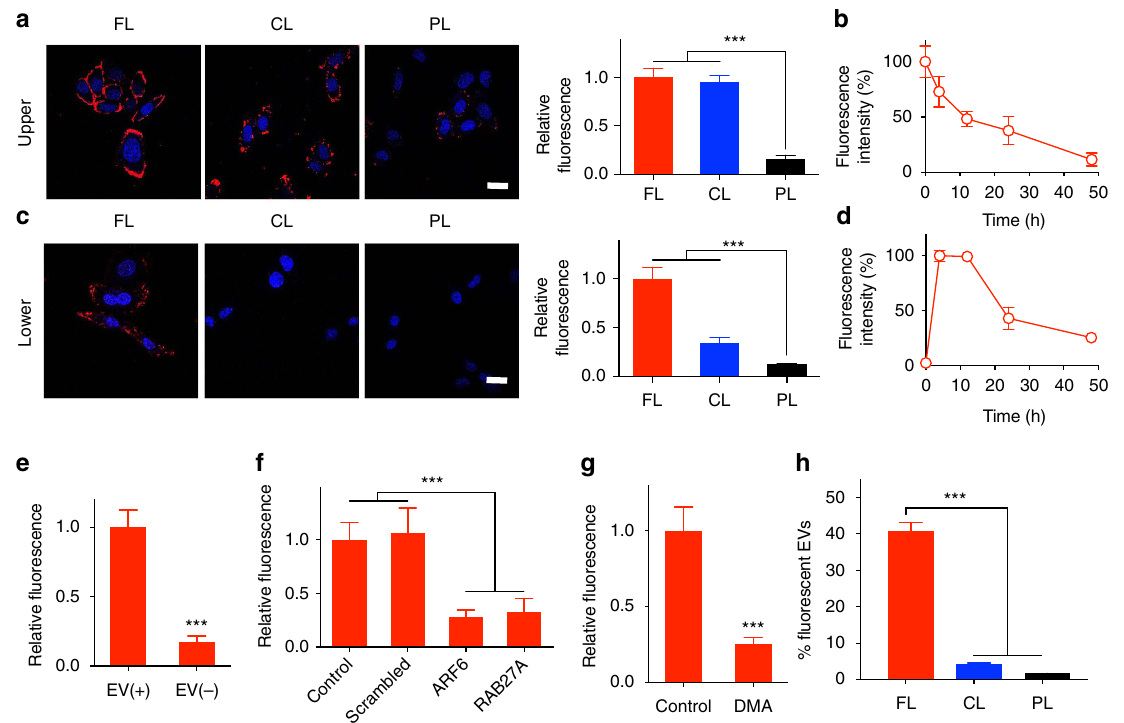
Figure 2 | Cell membrane-selective delivery and EV-mediated intercellular transfer of SR-lipids. ( a ) Confocal fluorescent microscopic images and fluorescence quantification of HeLa cells treated with fluorophore-streptavidin (SA; red) after liposome-mediated biotin-lipid delivery for 1h. ( b ) Time- dependent fluorescence change of cells after FL-mediated biotin-lipid delivery in a . ( c ) Confocal fluorescent microscopic images and fluorescence quantification of HeLa cells in the lower chamber of a transwell. Cells in the upper filter with 400-nm pores, treated with biotin-liposomes for 1h, were co-incubated with fresh cells in the lower chamber for 4h. The cells in the lower chamber were then incubated with fluorophore-SA (red) and imaged. ( d ) Time-dependent fluorescence change of lower-chamber cells after FL-mediated biotin-lipid delivery to the transwell filter cells in c . ( e ) Fluorescence quantification of HeLa cells treated with fluorophore-SA after treatment with EV-containing ( þ ) or EV-depleted ( (cid:2) ) supernatant collected from the cells treated with biotin-FLs. ( f ) Fluorescence quantification of HeLa cells in the lower chamber treated with fluorophore-SAs 4h after FL-mediated biotin-lipid delivery to siRNA (scrambled, ARF6 or RAB 27A)-pretreated cells in the upper transwell filter. ( g ) Fluorescence quantification of EVs produced from the cells treated with FLs containing fluorophore-lipids after DMA treatment. ( h ) Nanoparticle tracking analysis of EVs produced from the cells treated with liposomes containing fluorophore-lipids. Data are means ± s.e.m. ( n Z 10, *** P o 0.001, one-way analysis of variance (ANOVA) with Tukey post test for a and c ; n ¼ 3